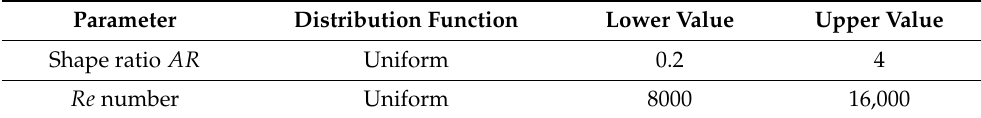
Table 1. Modeling parameters for the design of experiments.